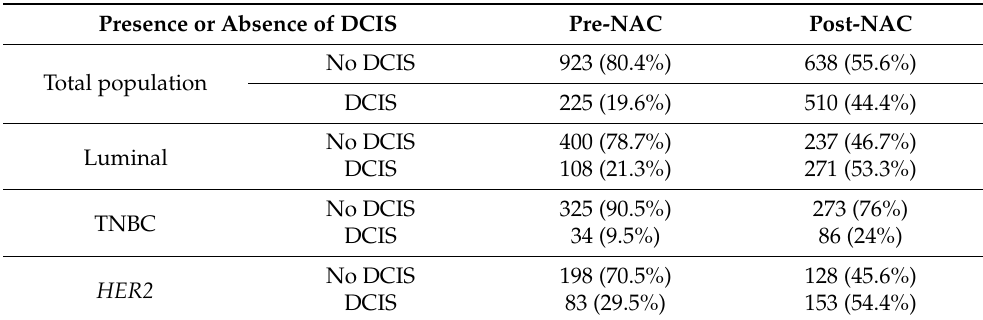
Table 3. Change in the proportion of samples presenting a DCIS component between the pre- and post-NAC